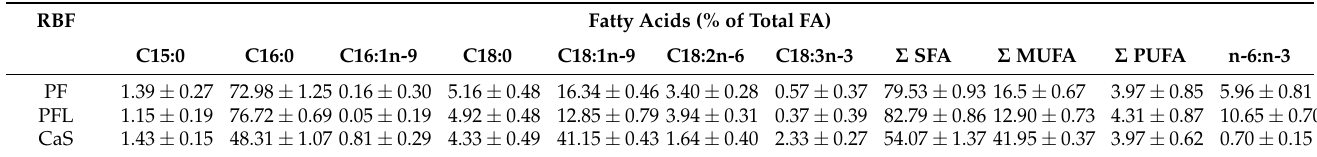
Table 1. Fatty acid profile of rumen bypass fats (RBF).